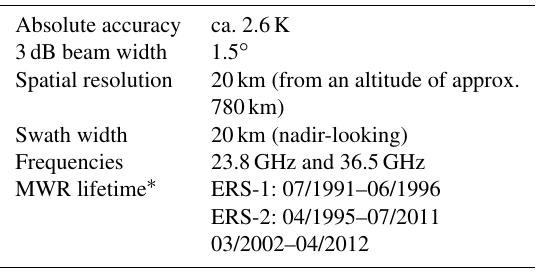
Table 1. Main characteristics of the microwave radiometer